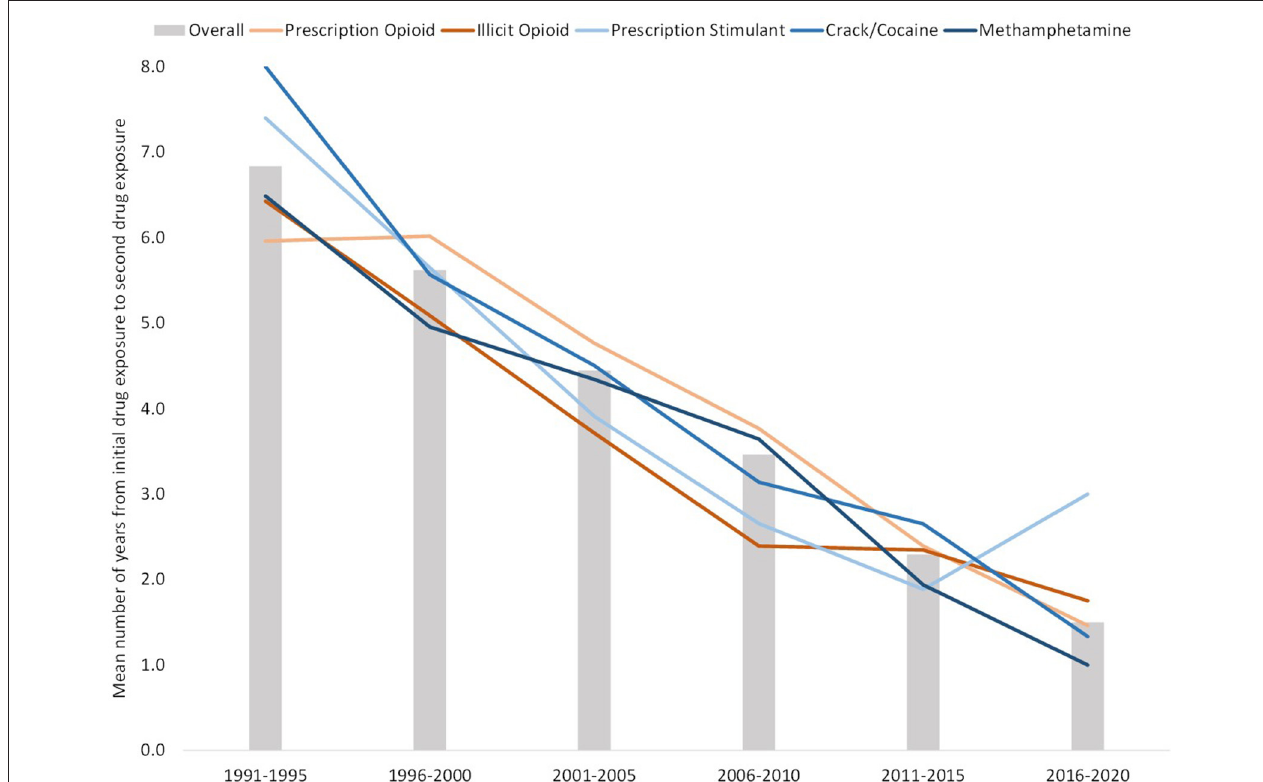
FIGURE 8 | Mean number of years between initial and second drug exposure, grouped by year of initial drug exposure. Bars reflect mean number of years between transitions for all drugs, with lines representing mean number of years between transitions between specific initial drugs and a secondary